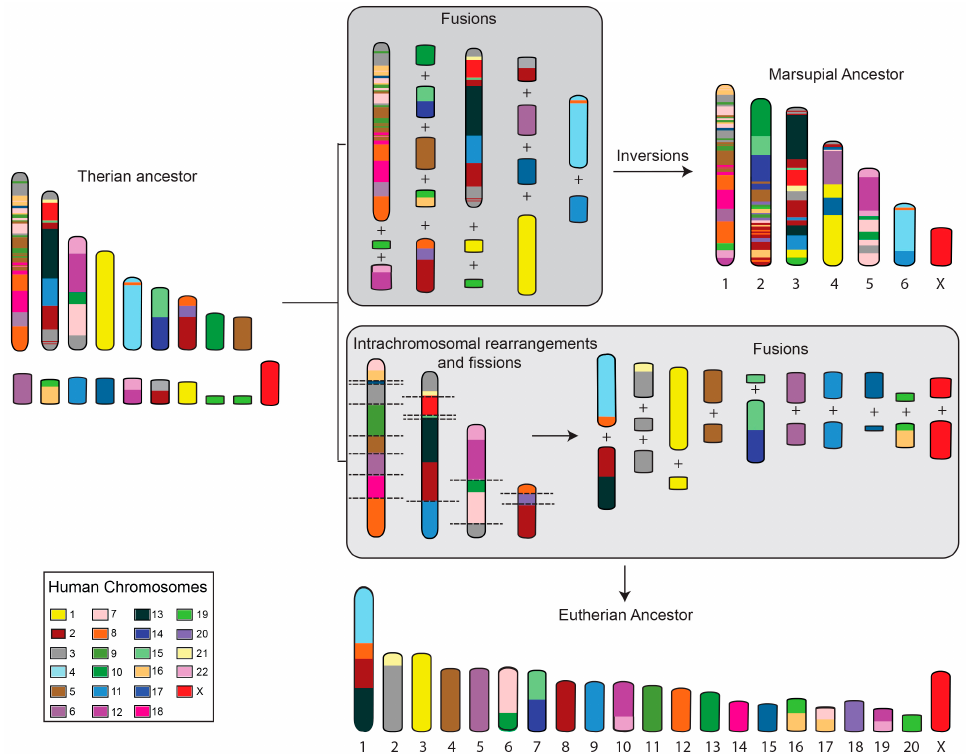
Figure 1. Predicted events leading to the proposed ancestral marsupial and eutherian karyotypes. Chromosomes have been color-coded to reflect their homology to human chromosomes. Chromosome fusions followed by inversions resulted in a 2 n = 14 marsupial ancestral karyotype [14] whereas a series of intrachromosomal rearrangements followed by fissions and fusions resulted in the predicted 2 n = 42 ancestral eutherian karyotypes [18].